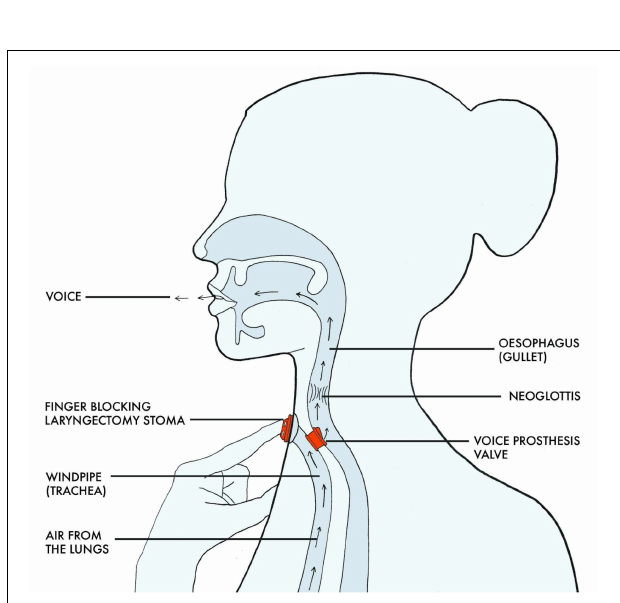
FIGURE 2 | Airflow and voicing in TE speech (Drawing, Claire